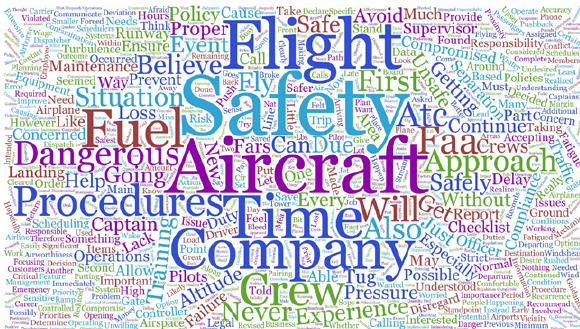
Figure 5. Word cloud of narrative elements coded as